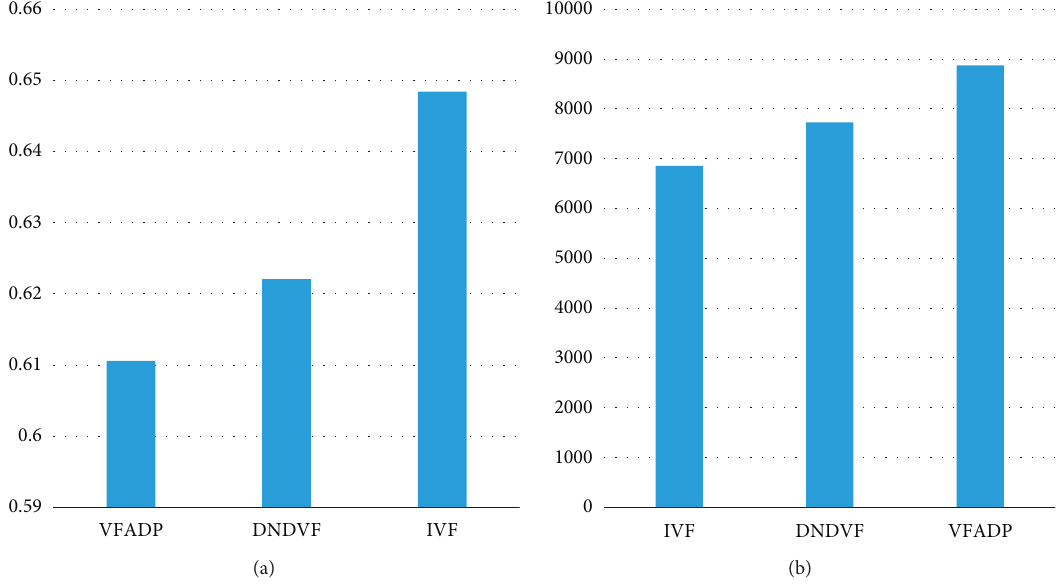
Figure 6: Coverage effect and moving distance in different algorithms when N � 80. (a) Coverage effect. (b) Moving distance (m).